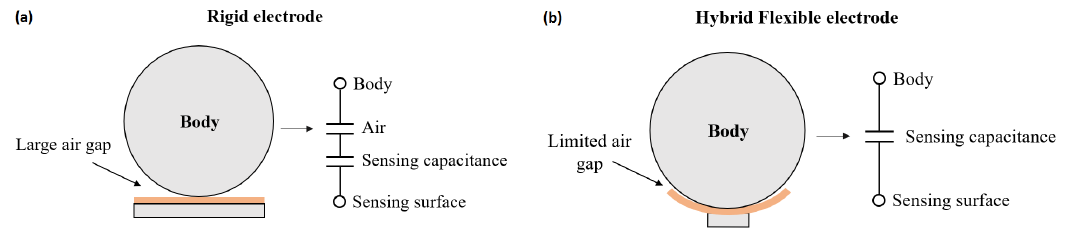
Figure 3. Schematized system geometry for: ( a ) Rigid electrode. ( b ) Hybrid Flexible electrode.